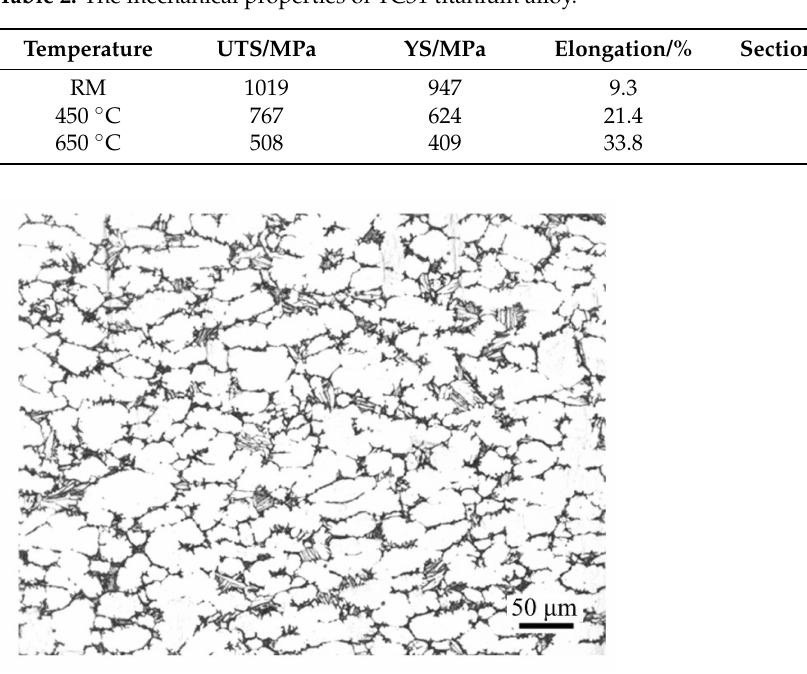
Table 2. The mechanical properties of TC31 titanium alloy.